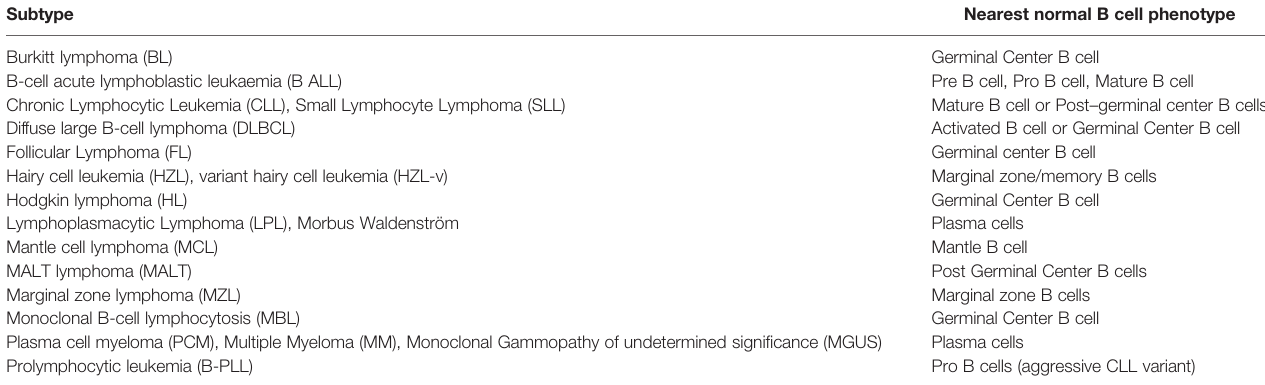
TABLE 1 | Major subtypes of B cell